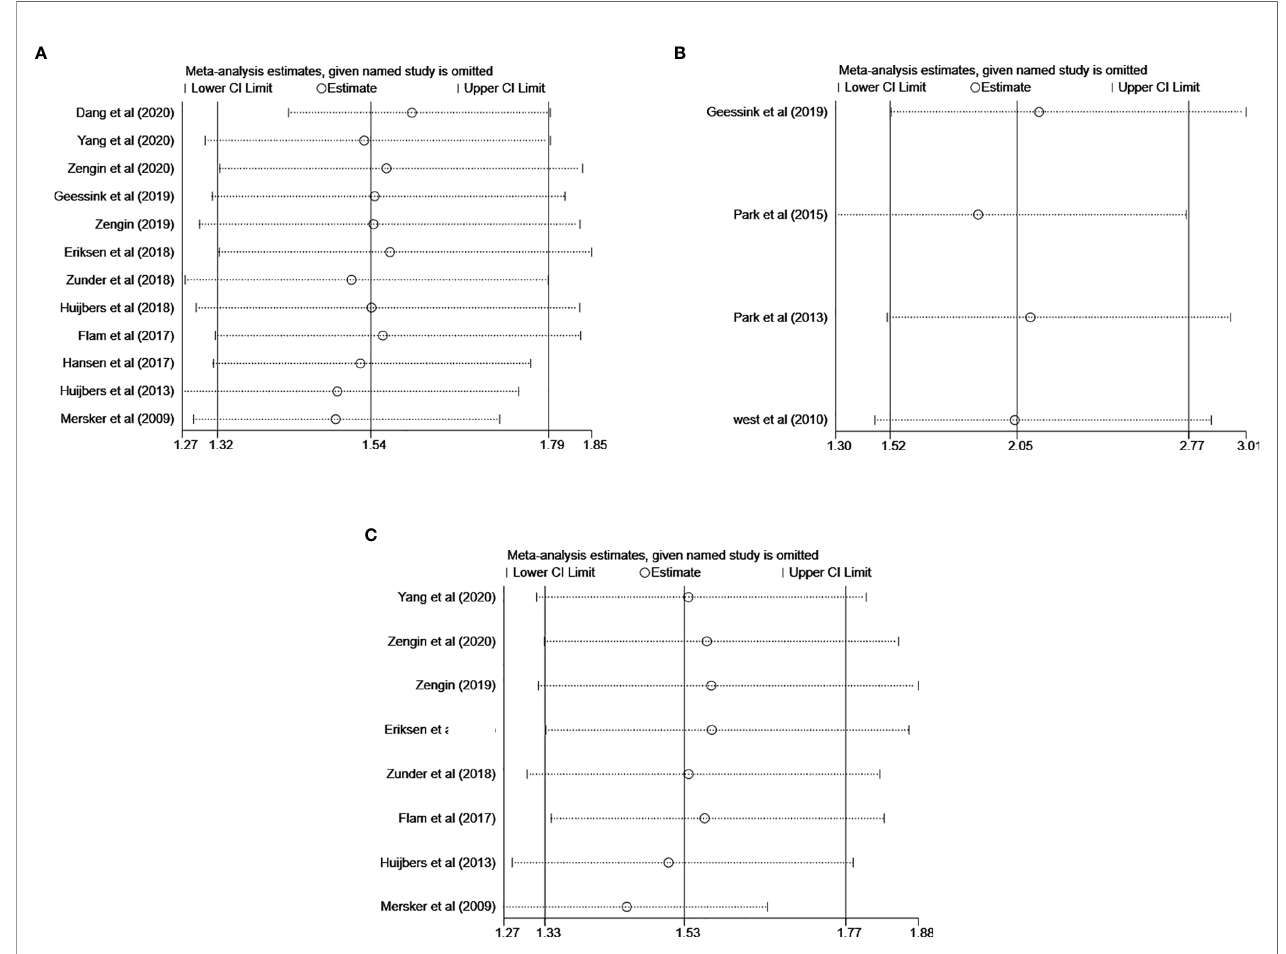
FIGURE 4 | Effect of individual studies on pooled HR for the prognostic value of TSR on RC. (A) Sensitivity analysis for DFS. (B) Sensitivity for CSS. (C) Sensitivity analysis for